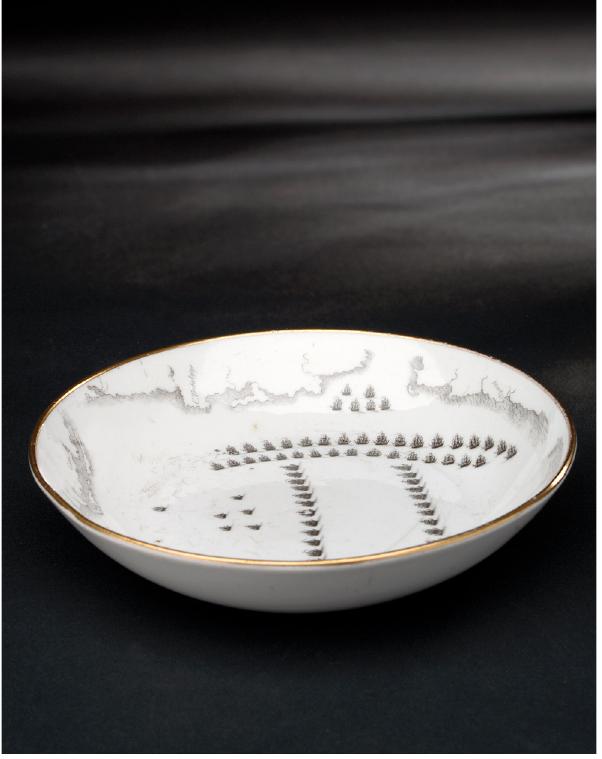
Figure 1: Saucer (Object ID AAA4966) © National Maritime Museum, Greenwich, London This porcelain saucer, probably from 1806, is part of a Trafalgar-themed tea set, which is on display in the gallery “Nelson, Navy, Nation” in the National Maritime Museum in Greenwich. It is black-and-white tableware, with the battle order of Trafalgar, the ships as they were deployed at the outset of the battle, as a transfer-printed decoration. “A compass rose and the coast line are shown around the edge of the saucer with the place names ‘Cadiz’, ‘C. Trafalger’ (sic), ‘C. Spartle’. There is a gilt line around the rim.”6 The